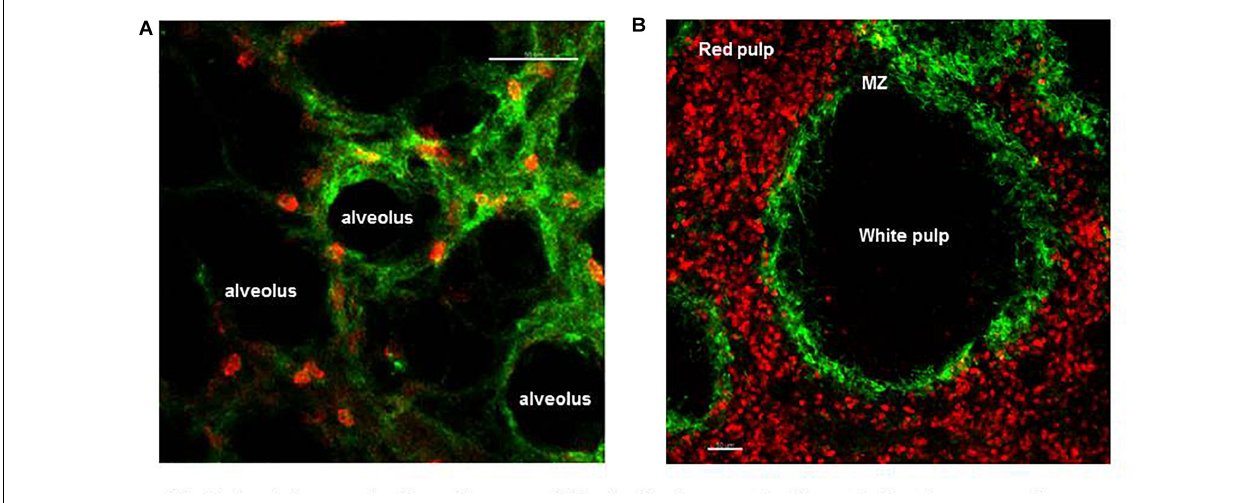
FIGURE 2 | Spatial organization of neutrophils in the lung and spleen during homeostasis. (A) Frame from lung IVM video showing marginated neutrophils (red) within the microvessels of the lung (green). (B) Precision cut spleen slice showing tissue resident neutrophils (red) and margiant zone macrophages (green) delimiting the MZ. Scale bar 50 µ